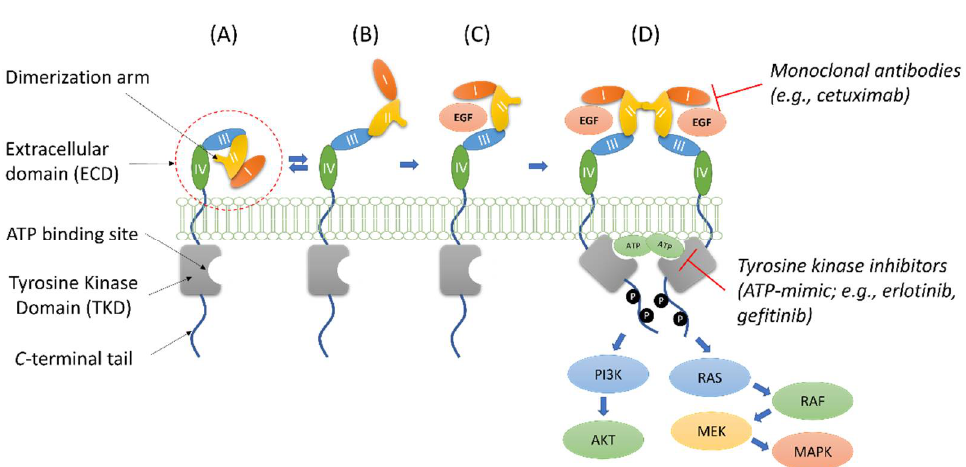
Figure 1. Structure and simplified dynamics representation of EGFR. The auto-tethered fully inactive conformation of EGFR ( A ) is in equilibrium with a partially opened state ( B ) that can be stabilized by the binding with EGF ( C ). The EGF-activated conformation can dimerize ( D ) leading to receptor autophosphorylation and activation of the AKT and MAPK cascades that mediate cell survival and proliferation. The target regions for monoclonal antibodies and ATP-mimic compounds are also reported in ( D ).